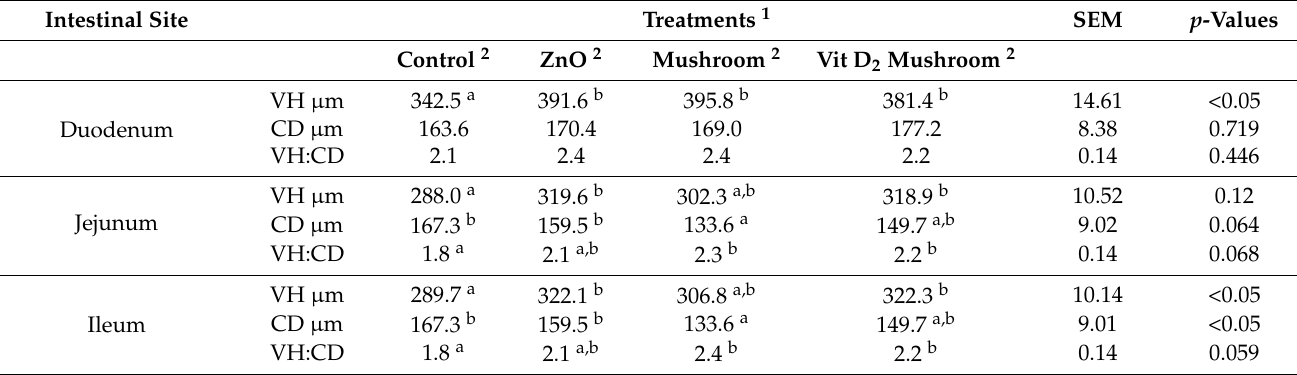
Table 4. Effect of dietary treatment on villus height and crypt depth in the small intestine (least square means with their standard